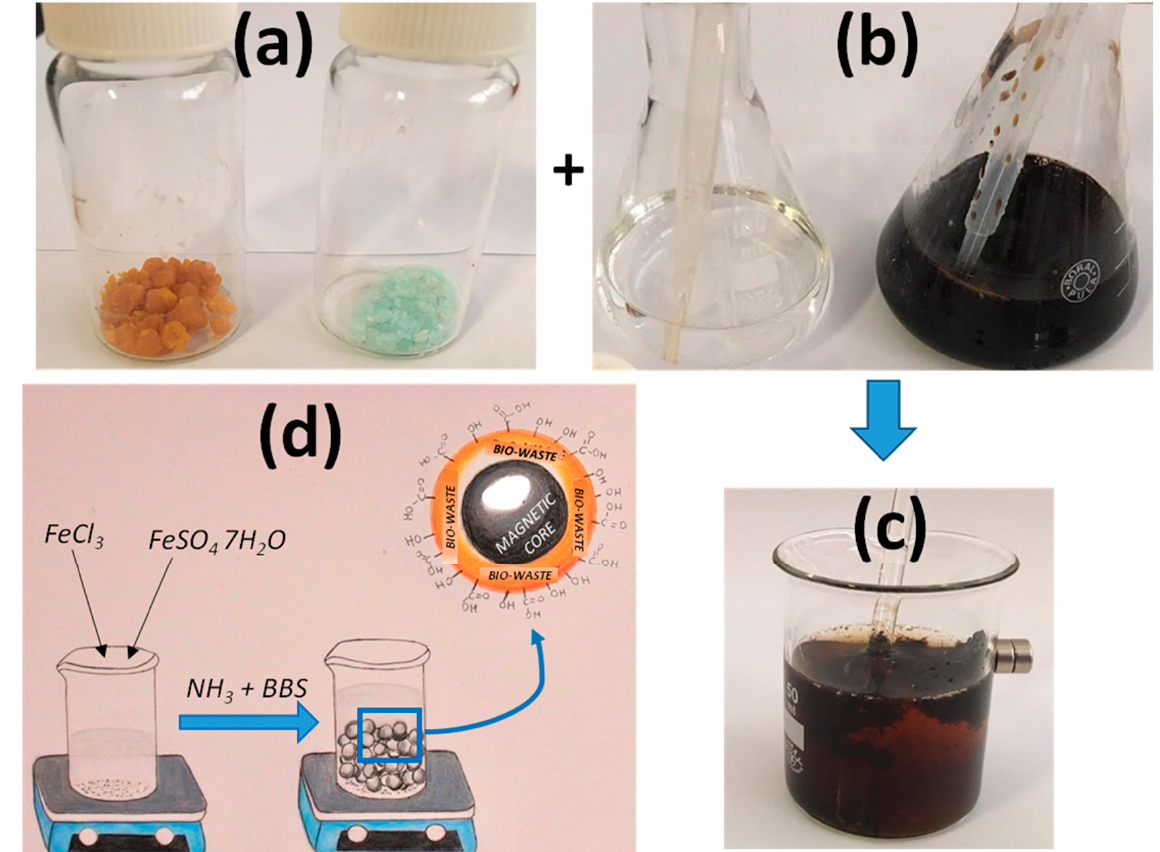
Figure 1. Steps for the preparation of magnetic material. Powders of FeCl 3 and FeSO 4 ( a ) are dissolved in water and combined with NH 3 and BBS solution ( b ) under a fume hood or in open air; after stirring and ripening the magnetic material is formed ( c ); ( d ) reports a pictorial representation of the synthesis.